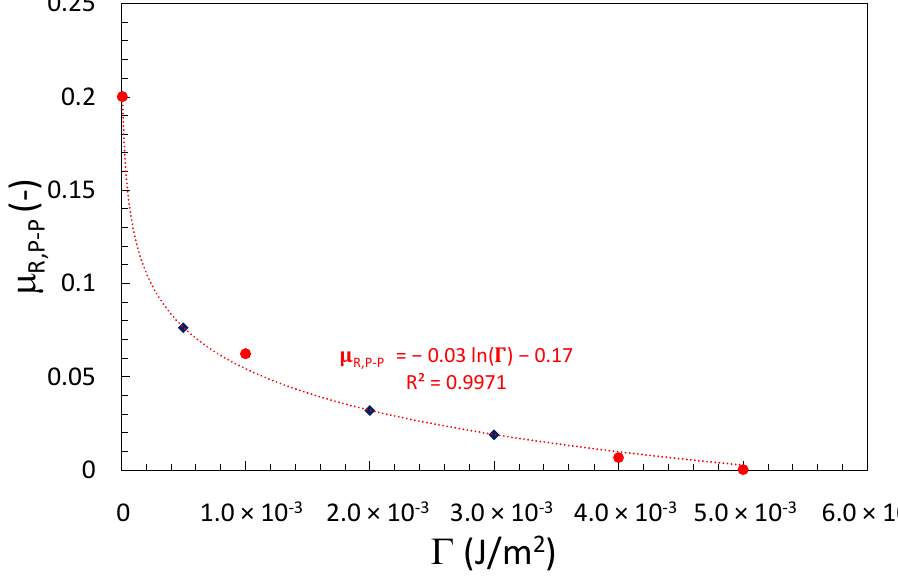
Figure 10. Logarithmic curve representing all the possible pairs of the parameters ( µ R, P − P and Γ ) for which α from the simulation ( α (cid:2929)(cid:2919)(cid:2923) ) is matched by the experimental one. Table 4. Pairs of parameters ( Γ and μ (cid:2902),(cid:2900)(cid:2879)(cid:2900) ) from the logarithmic curve for which the experimental α and that obtained from the simulation ( α (cid:2929)(cid:2919)(cid:2923) ) are matched. σ is the standard deviation of α from the simulation.